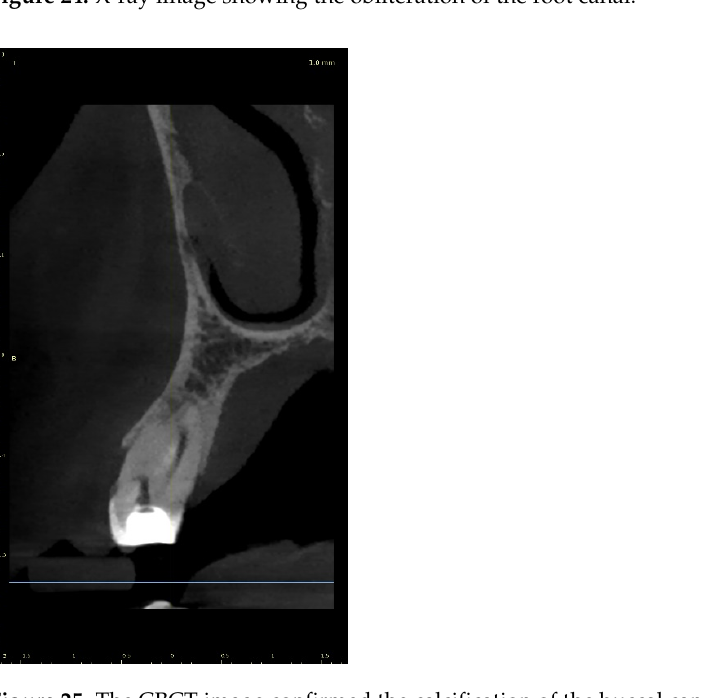
Figure 24. X-ray image showing the obliteration of the root canal.